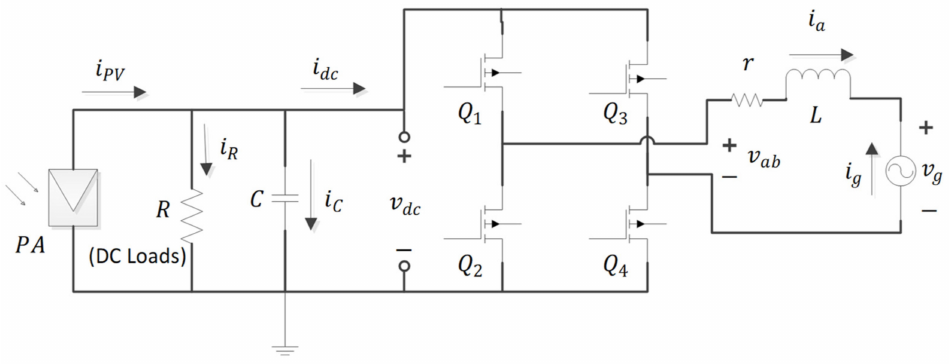
Figure 1. Main grid interconnection system